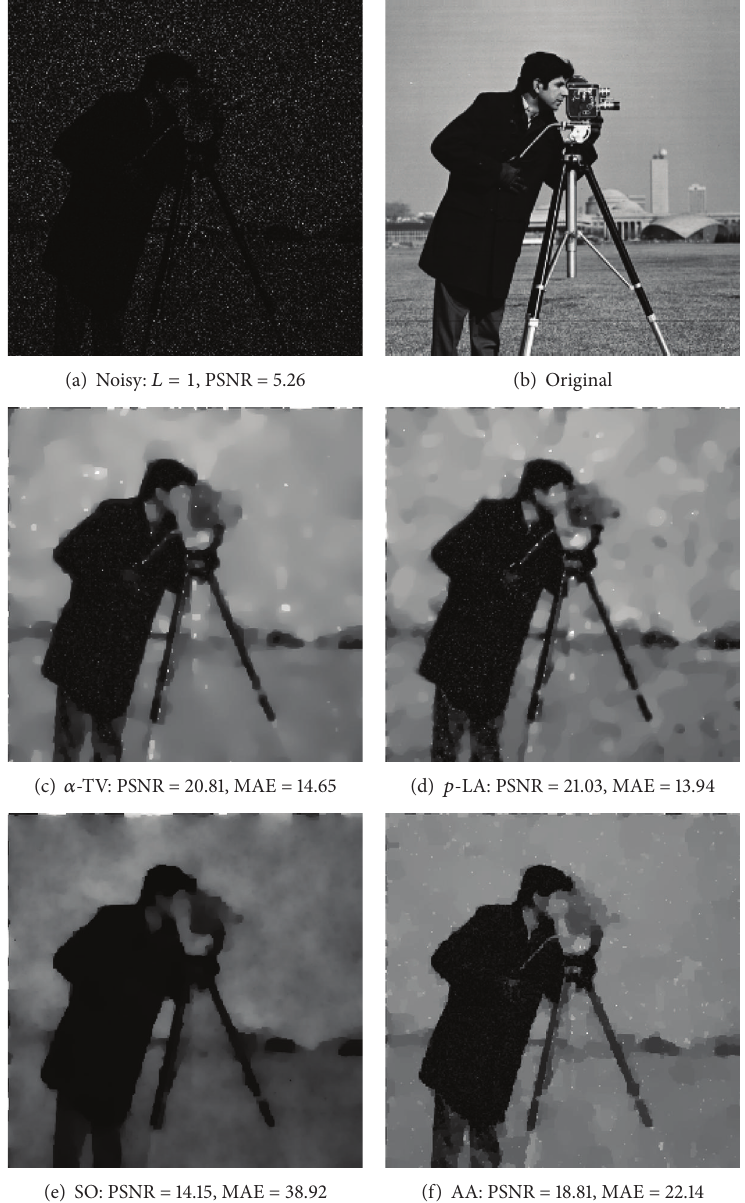
Figure 8: Cameraman image ( 512 × 512 ). (a) Noisy image corrupted by speckle noise for 𝐿 = 1 in (8). (b) Original image. (c) Our algorithm by 𝛼 -TV, 𝜎 = 2 , 𝑘 = 0.01 , and 𝜏 = 0.05 . (d) Our algorithm by 𝑝 -LA, 𝑝 𝑈 = 1.3 . (e) SO algorithm, 𝜆 = 0.04 , 𝛼 = 0.25 . (f) AA algorithm, 𝜆 = 125